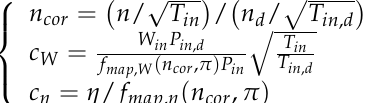
Figure 3. Combustor inverse calculation. In the hypothetical condition of the given Fan and HPC air mass flow ( 2 W and 25 W ) which are chosen as adjustment parameters in the compressor component AIM, combus- tion efficiency is estimated: